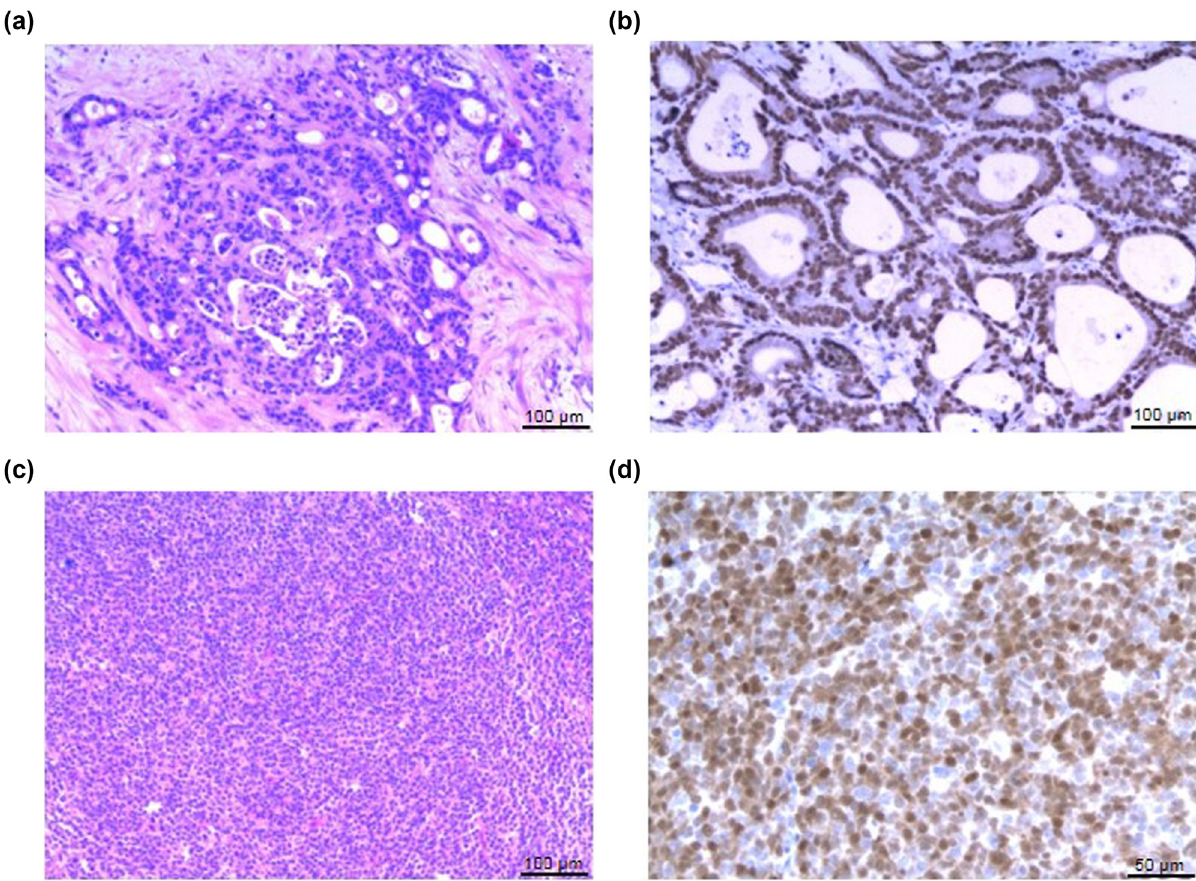
Figure 2: ( a ) HE staining of postoperative intestinal cancer specimen, original magni fi cation × 100. ( b ) Positive with CDX - 2 (× 100 ) . ( c ) HE staining of postoperative MCL specimen (× 100 ) . ( d ) Positive with cyclin D1 (× 200 )